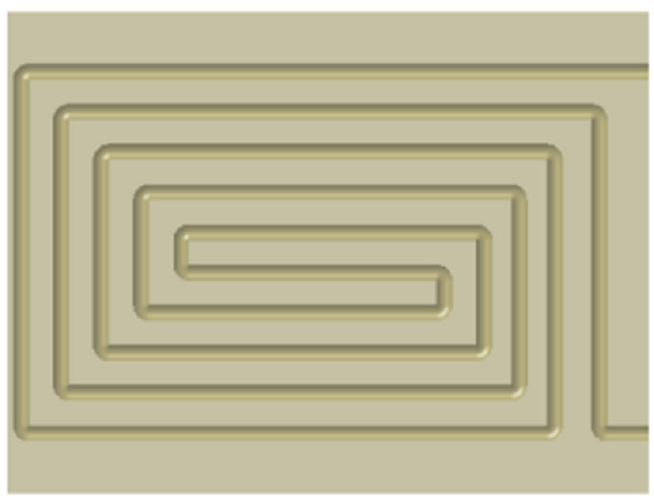
Figure 6. Simulation model diagram of the IGBT module.